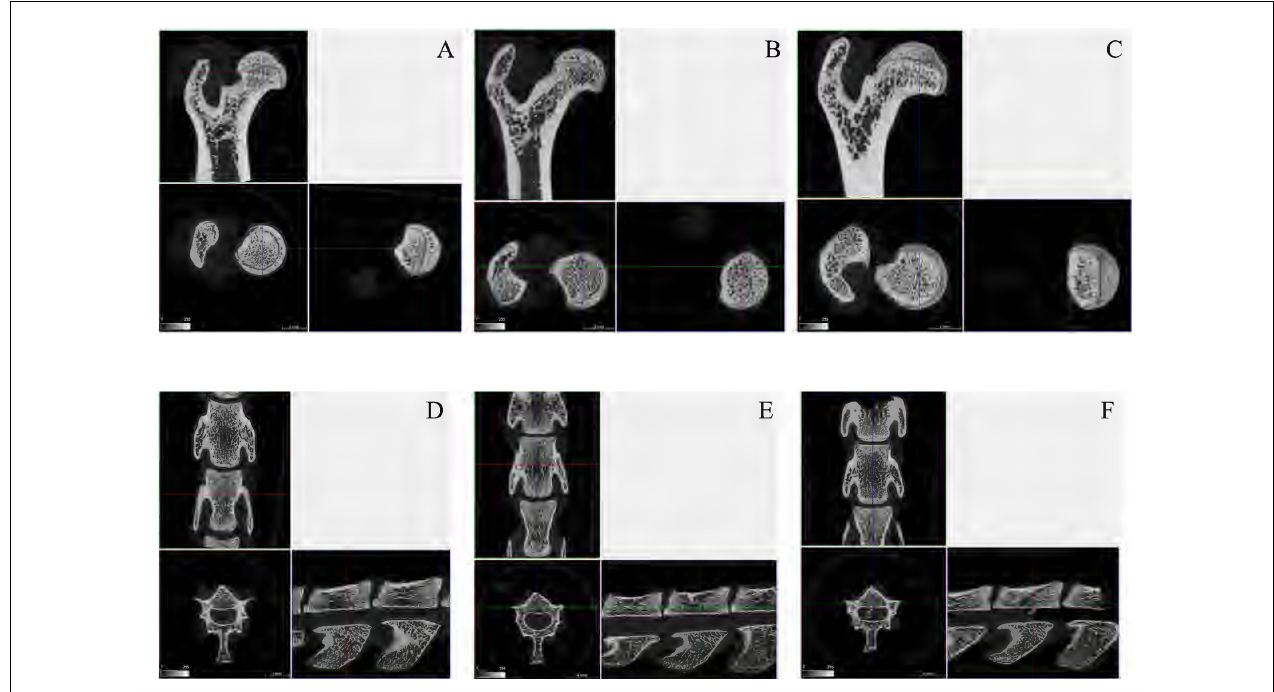
FIGURE 3 | Bone micro-CT. (A–C) Representative micro-CT images obtained from femurs of the several study group. (A) tCTRL, (B) tMP+S, (C) tMP+PDRN. (D–F) Representative micro-CT images obtained from spines of the several study group. (A) tCTRL, (B) tMP+S, (C)